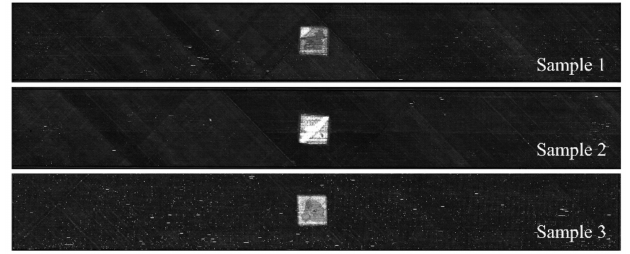
Figure 2. Ultrasonic scanning results of samples with delamination.